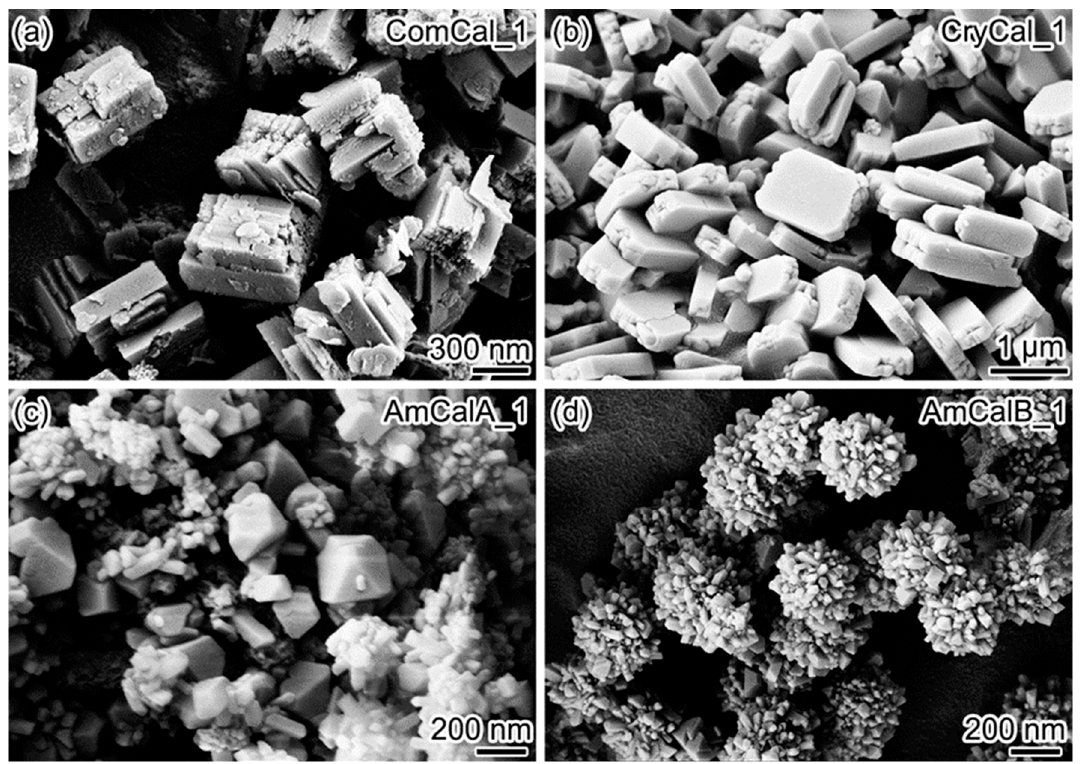
Figure 6. The SEM images of ComCal_1 ( a ), CryCal_1 ( b ), AmCalA _1 ( c ), and AmCalB_1 ( d ).